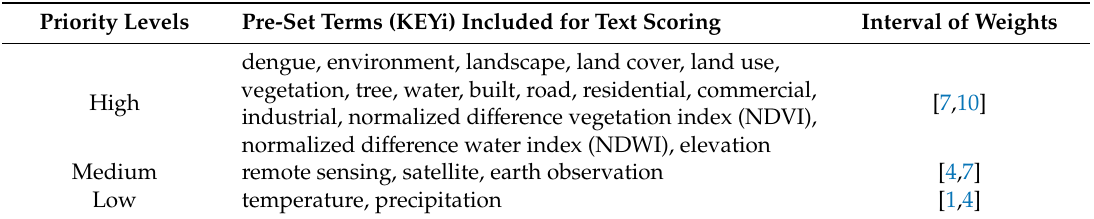
Table 1. Pre-set terms and priority levels for titles and abstract scoring. Priority Levels Pre-Set Terms (KEYi) Included for Text Scoring Interval of Weights dengue, environment, landscape, land cover, land use, vegetation, tree, water, built, road, residential, commercial, High industrial, normalized di ff erence vegetation index (NDVI), Medium remote sensing, satellite, earth observation Low temperature,